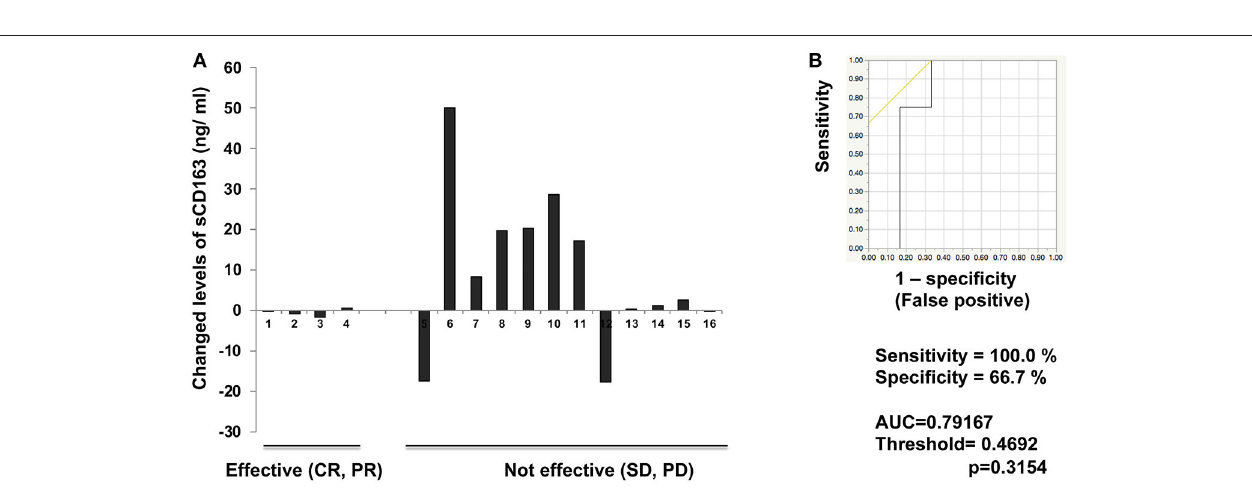
FIGURE 1 | Serum levels of sCD163 and ROC curve in cutaneous melanoma . Serum level changes of sCD163 in each patient ( n = 59) (A) on day 42. The ROC curve was applied to calculate cut-offs for sCD163 serum levels and AUC (B) . Cut-offs were determined to distinguish responders from nonresponders using Youden’s index.